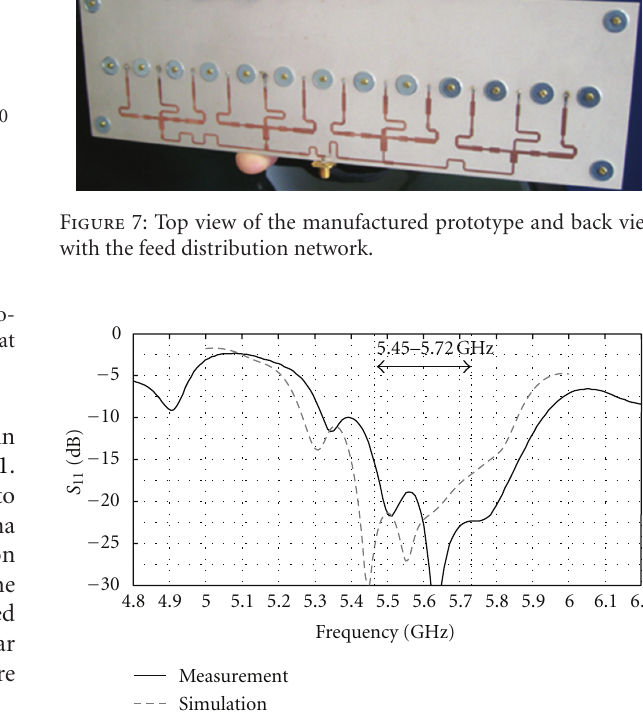
Figure 8: S 11 comparison between simulation and manufactured